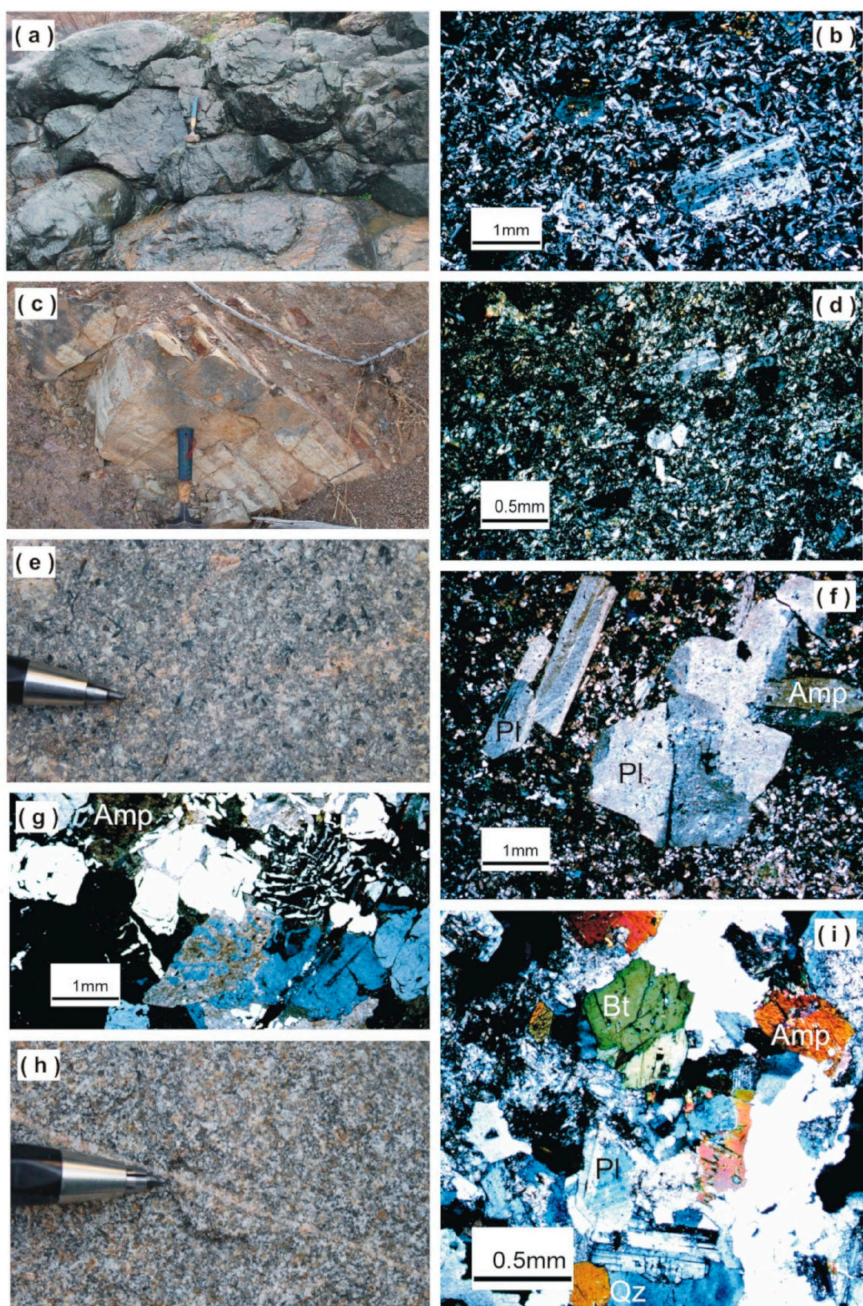
Figure 2. TocadaMouravolcano-sedimentarycomplex(Visean): ( a )Maficpillow-lavas;( b ) microphotograph of a trachyandesite; ( c ) Felsic lavas; ( d ) microphotograph of rhyolite; ( e ) Baleiz ã o porphyry (Bashkirian); ( f , g ) microphotographs showing plagioclase and amphibole phenocrysts surrounded by a fine-grained quartz-feldspathic matrix, and intergrowths of quartz and K-feldspar; ( h ) fine-grained Alc á çovas quartz diorite (Bashkirian); ( i ) microphotograph showing zoned plagioclase, amphibole, biotite and